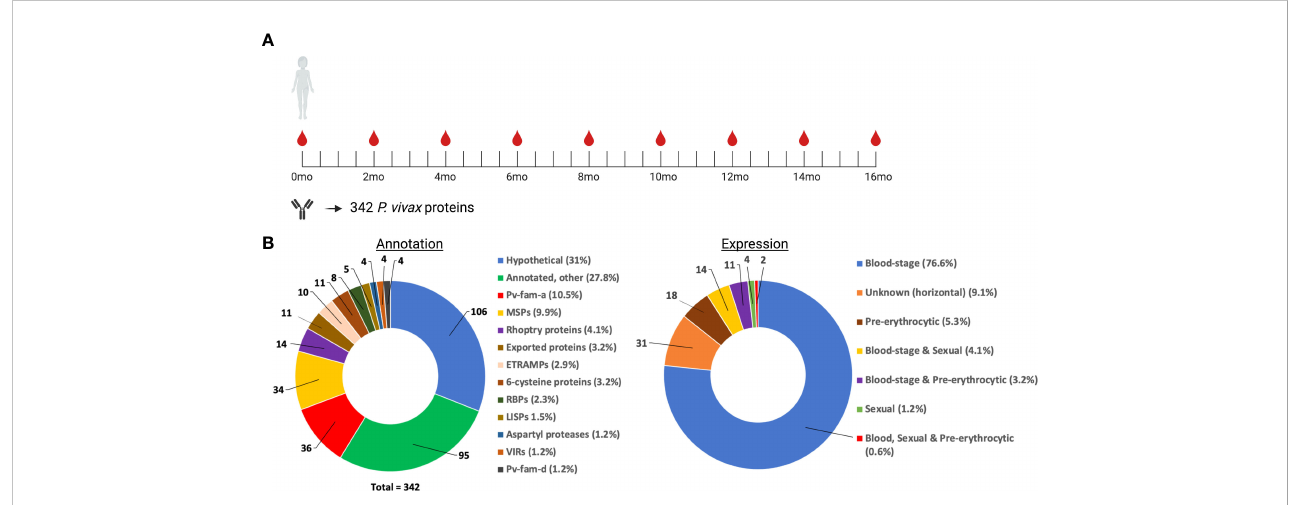
FIGURE 1 Overview of study design. (A) IgG antibodies were measured in 183 children at the fi rst time-point of the longitudinal study. PCR data was available every 8 weeks throughout the 16-month long study, in addition to morbidity data that was obtained at every visit (every 2 weeks). (B) IgG antibodies were measured against 342 P . vivax proteins with the bottom plots providing a summary of the annotation and expression stages covered. Created with